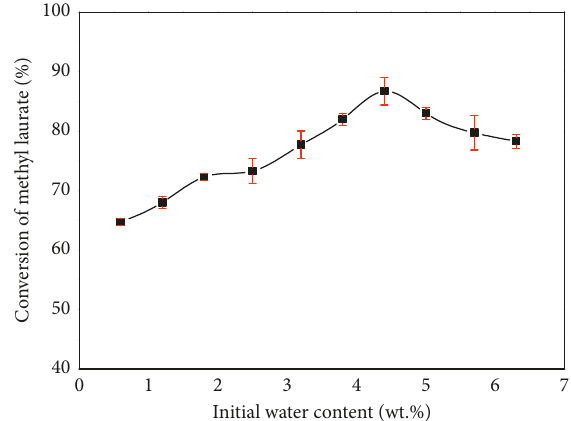
Figure 6: Effect of initial water content on lipase-catalyzed transesterification of decylglycerol with methyl